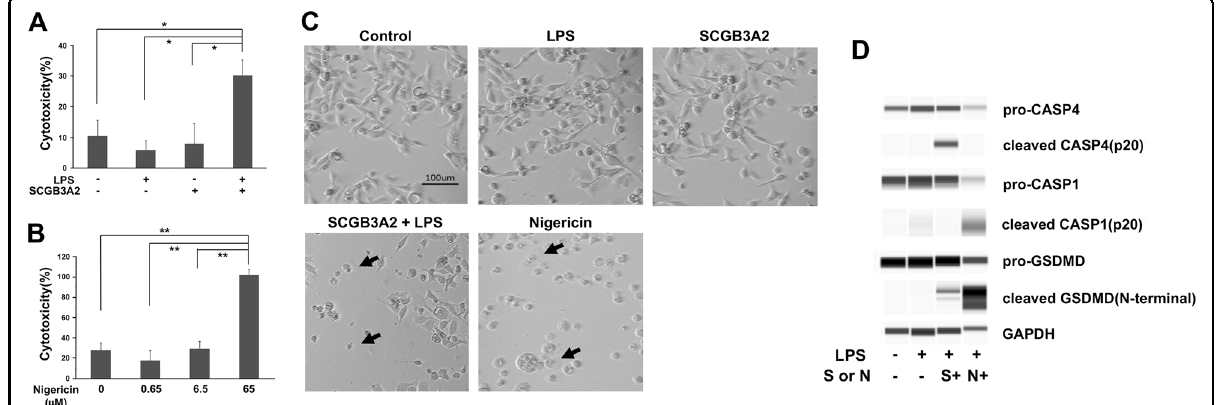
Fig. 3 Analysis of non-canonical in fl ammasome pathway. A LDH cytotoxicity assay in the presence of LPS or SCGB3A2 alone, or the two together (SCGB3A2 + LPS). B LDH cytotoxicity assay in the presence of various amount of nigericin. Average ± SD from more than three independent experiments. * P < 0.01, ** P < 0.0001 by Tukey ’ s multiple comparison. C Morphology of cells cultured in the presence of LPS or SCGB3A2 alone, SCGB3A2 + LPS, or nigericin for 3 h. For nigericin-treated group, cells were primed with LPS before addition of nigericin. Black arrow indicates ballooned cells, characteristic feature of pyroptosis. D Western blotting for the cleaved forms of CASP1 (p20), CASP4 (p20), and GSDMD (N-terminal). S: SCGB3A2, N: nigericin. Experiments were repeated more than twice and same results were obtained.